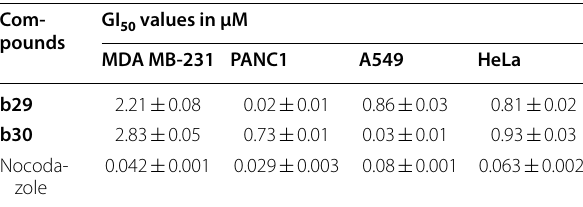
Table 26 Anticancer activity of triazole/isoxazole functionalized pyridopyrimidine